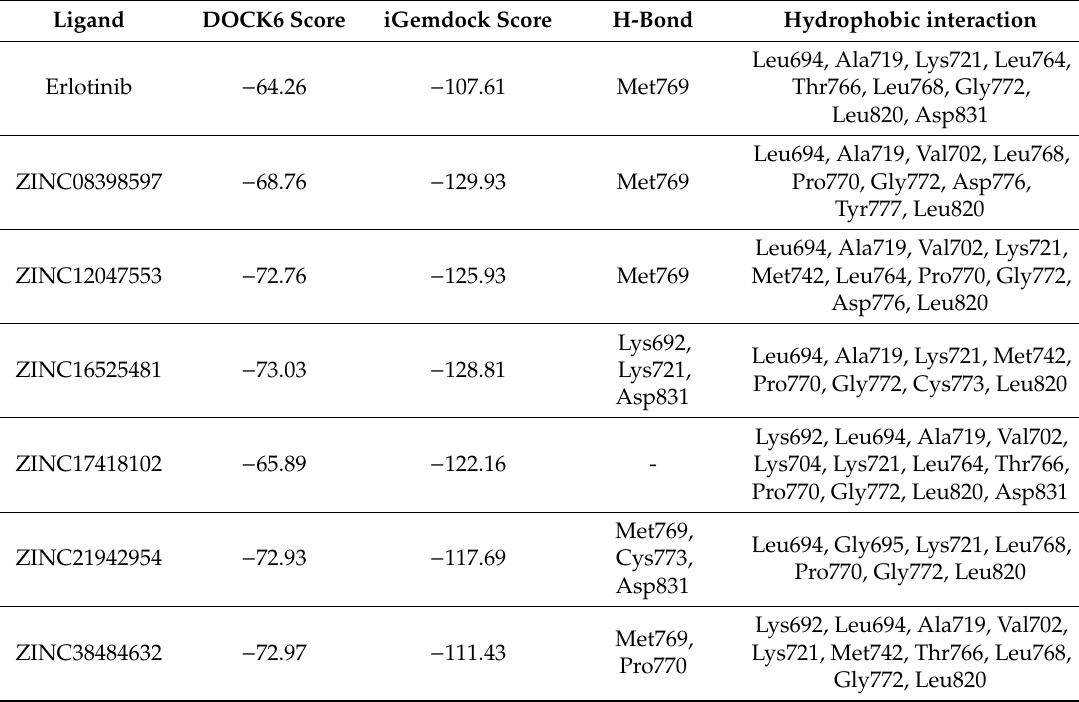
Table 1. EGFR-ligand interactions recorded during